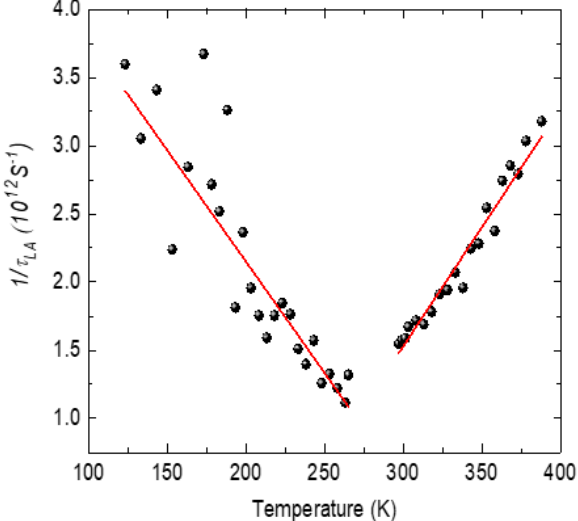
Figure 11. Plot showing 1 / τ LA as a function temperature for the LA phonon of PST. Points are the experimental data and the solid line is the fit of Equation (16).